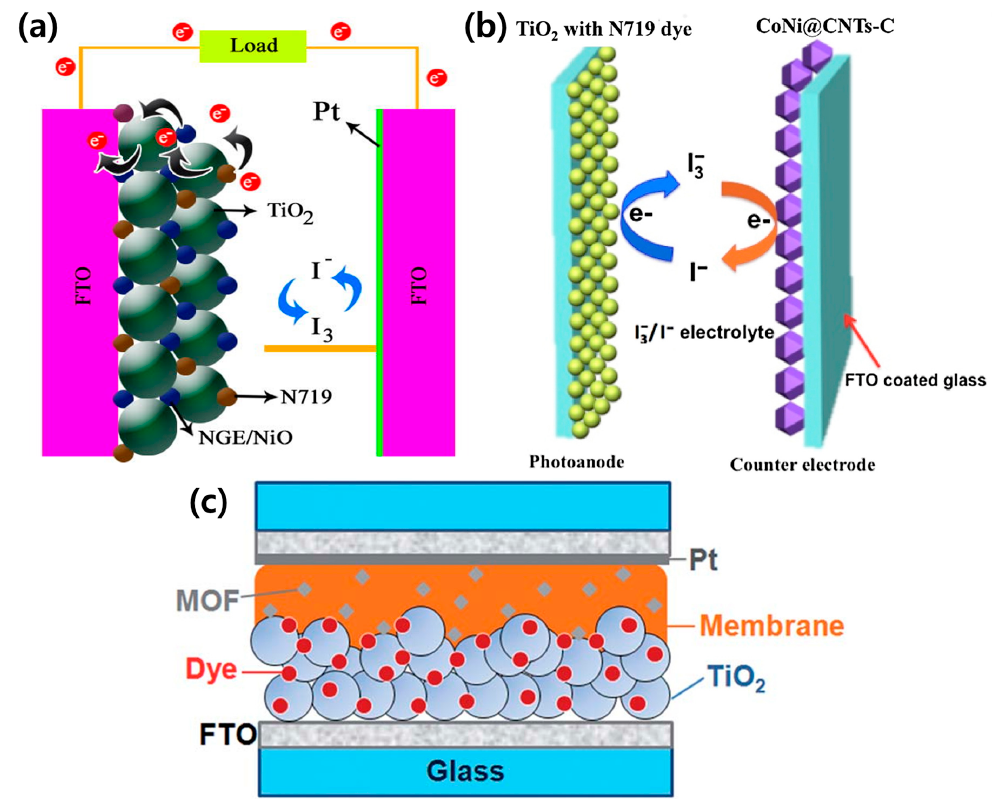
Figure 5. Schematic of a DSSC configuration using MOFs as the ( a ) photoanode [85], ( b ) counter electrode [90], and ( c ) electrolyte [81]. Reproduced form [81] with permission from The Royal Society of Chemistry. Reprinted from [85] with permission. Copyright© 2017, Elsevier. Reprinted from [90] with permission. Copyright© 2017, Elsevier.